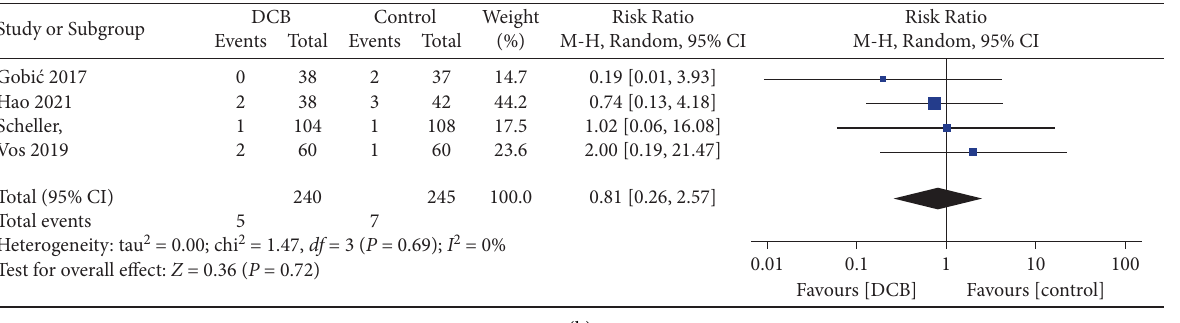
Mean Difference IV, Random, 95% CI